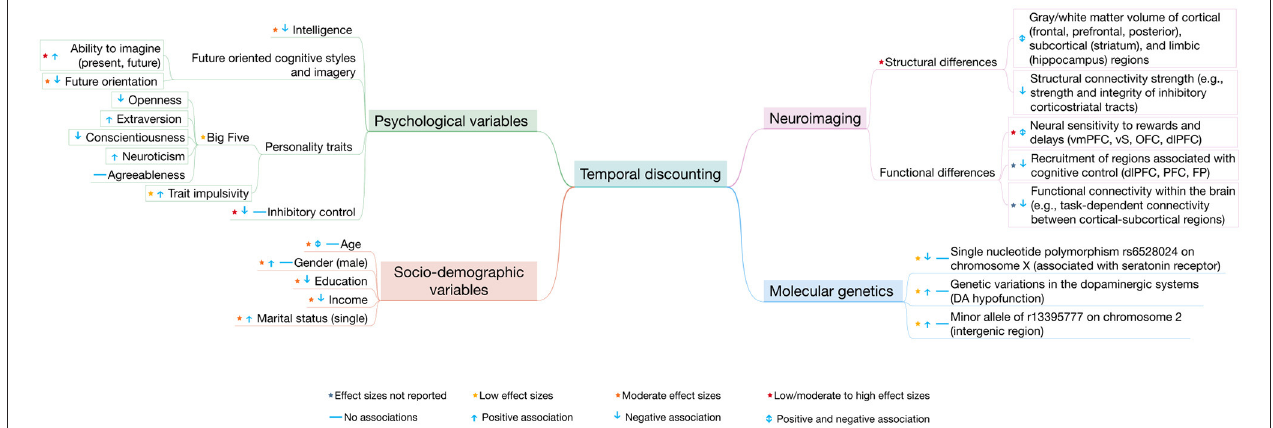
FIGURE 2 | Summary of the associations between temporal discounting and socio-demographic, psychological, neuroimaging, and molecular genetic variables. The figure in a simplified way summarizes how the different variables relate to (steep) temporal discounting. However, the relation of these variables to temporal discounting is far from being so simple and isolated (as it may appear in the figure) as these variables often interact with each other. Low effect sizes are considered d (or r ) < 0.15; moderate effect sizes are considered 0.15 ≤ d (or r ) ≤ 0.35; high effect sizes are considered d (or r ) > 0.35. vmPFC, ventromedial prefrontal cortex; vS, ventral striatum; OFC, orbitofrontal cortex; dlPFC, dorsolateral prefrontal cortex; PFC, prefrontal cortex; FP, frontal pole; DA,